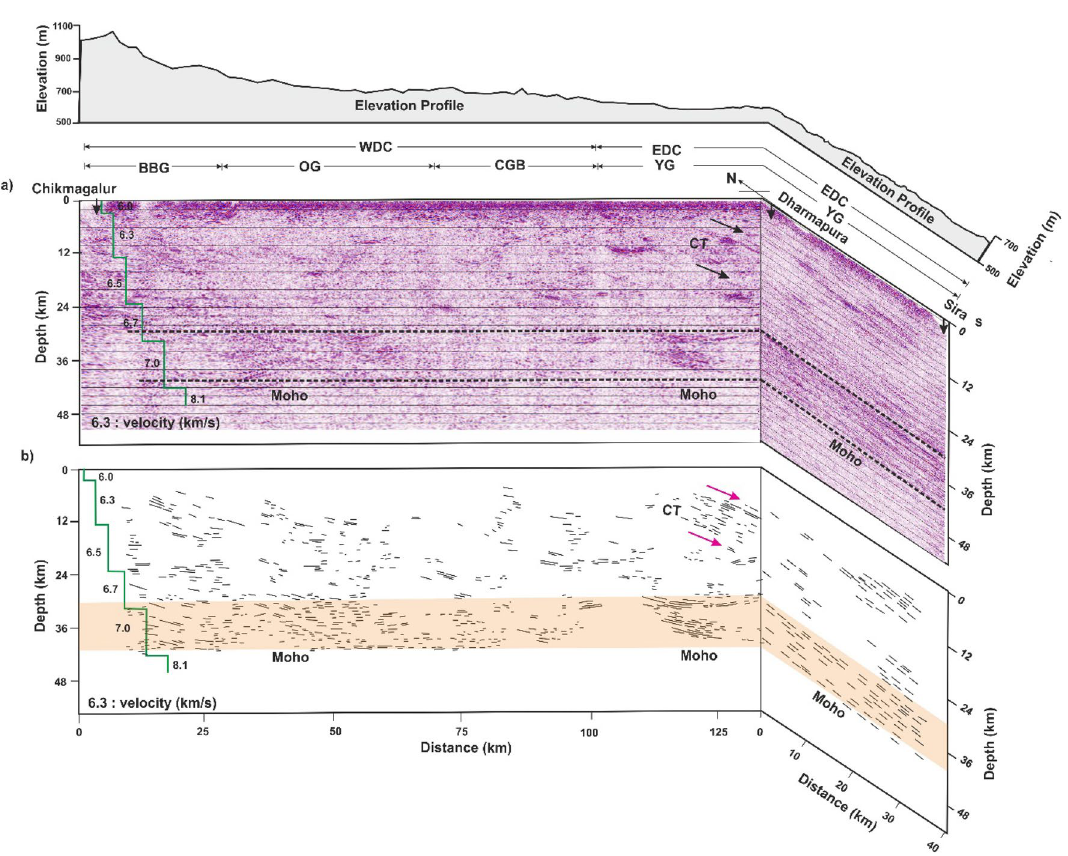
Figure 8. ( a ) Three-dimensional crustal seismic images along 130 km long Chikmagalur-Dharmapura, part of the (NE-SW) main profile and Dharmapura-Sira, the southern part of (N-S) cross-profile. The velocity-depth model of the main profile (Vijaya Rao et al. 11 ) derived from the coincident refraction profile is marked over the seismic section. YG-Younger Granite; CGB-Chitradurga Greenstone Belt; CG-Closepet granite; EDC-Eastern Dharwar Craton; WDC-Western Dharwar Craton. The dashed lines from 30 to 40 km depth indicate the top and bottom of the subhorizontal reflection band observed in the lower-crust of the main and cross-profiles. The dashed line bottom indicates the Moho. ( b ) Line drawing showing prominent reflection bands from main and cross-profile. Elevation along both profiles are marked over the seismic